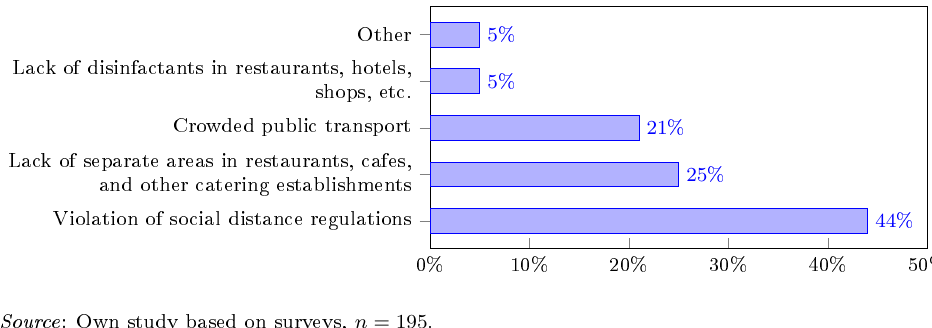
Figure 5: Assessment of the safety level in cities during coronavirus threat